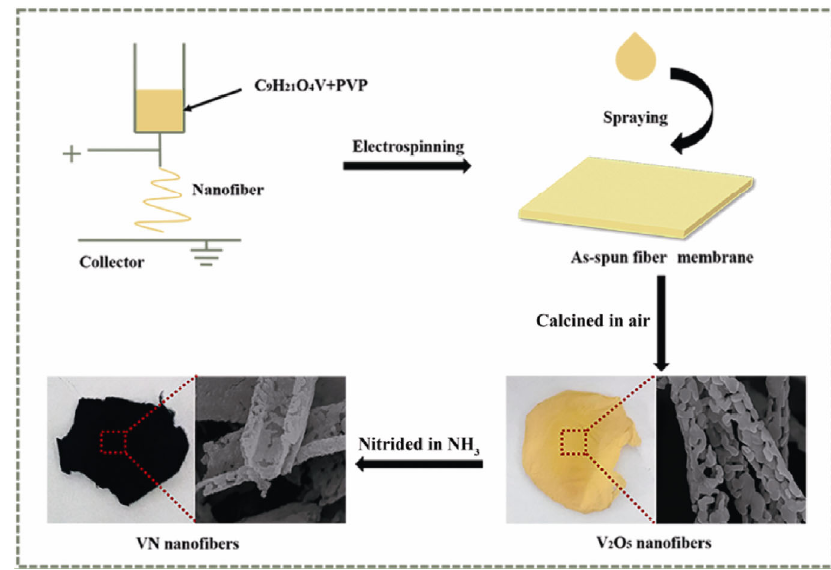
Fig. 1 Schematic illustration for fabricating VN